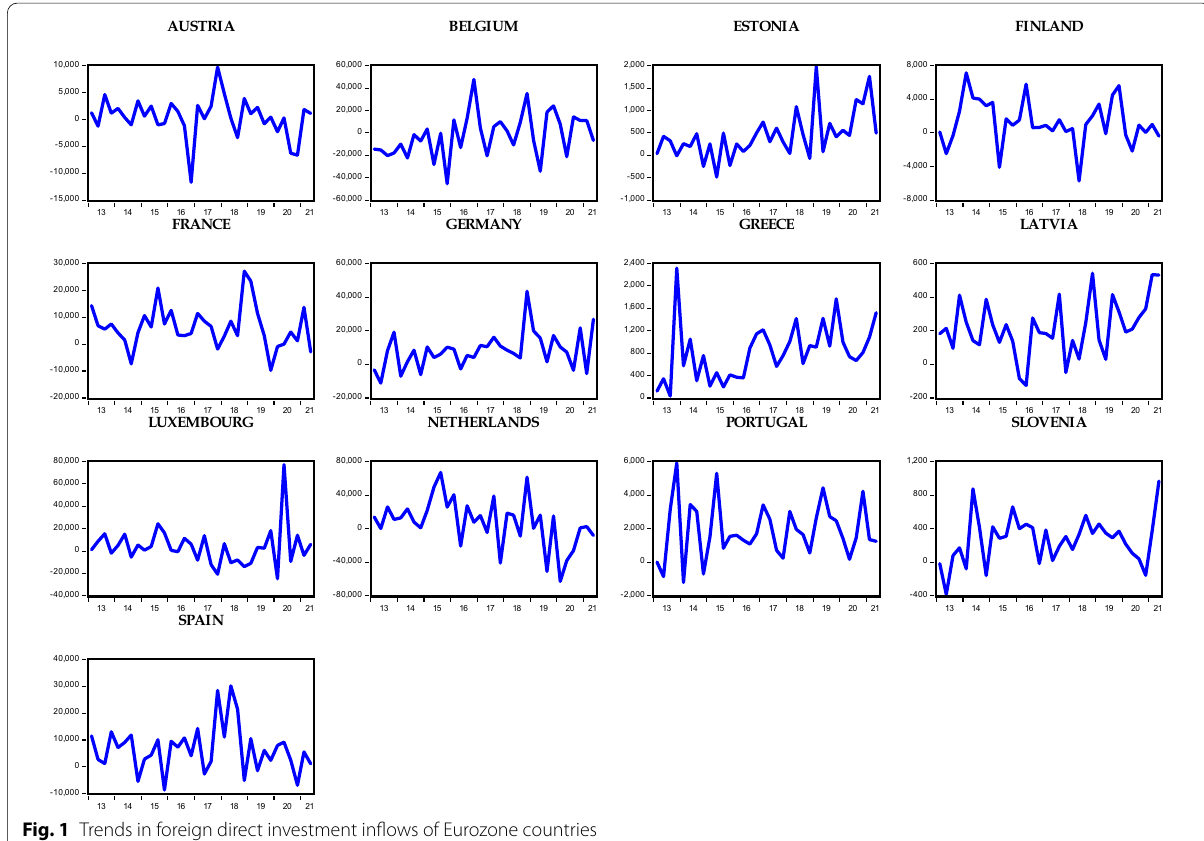
Fig. 1 Trends in foreign direct investment inflows of Eurozone